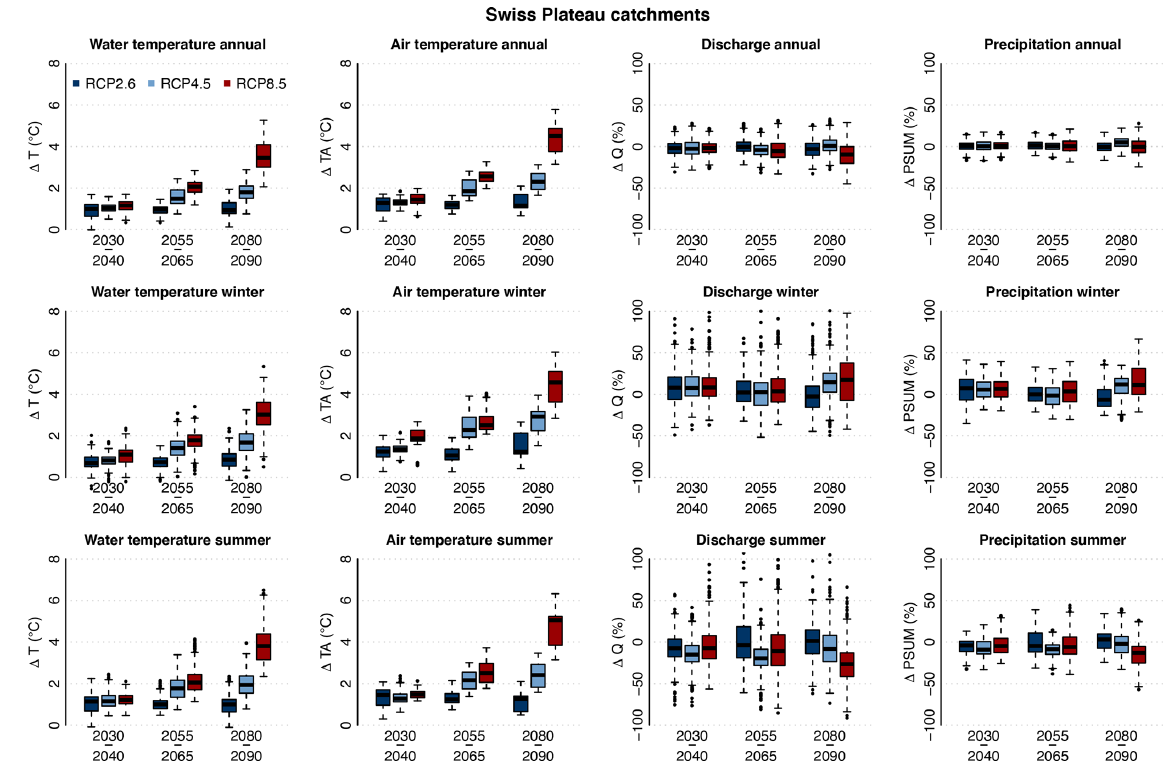
Figure 4. Changes in river temperature ( (cid:49)T ), air temperature ( (cid:49) TA), discharge ( (cid:49)Q ), and precipitation ( (cid:49) PSUM), from left to right column, over the periods 2030–2040, 2055–2065, and 2080–2090 compared to the reference period 1990–2000 for the Swiss Plateau catchments and for the three RCPs. The first row shows the annual changes, the second row the winter seasonal changes, and the last row the summer seasonal